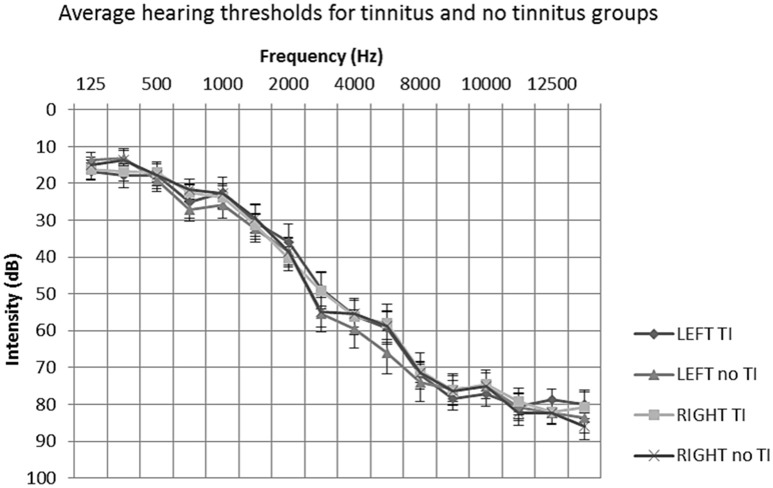
Mean average audiometric thresholds for tinnitus and no tinnitus groups. Post hoc t-tests of average hearing thresholds found no significant differences between or within participant groups (P > 0.05). Error bars represent one standard error of the mean. TI, tinnitus.